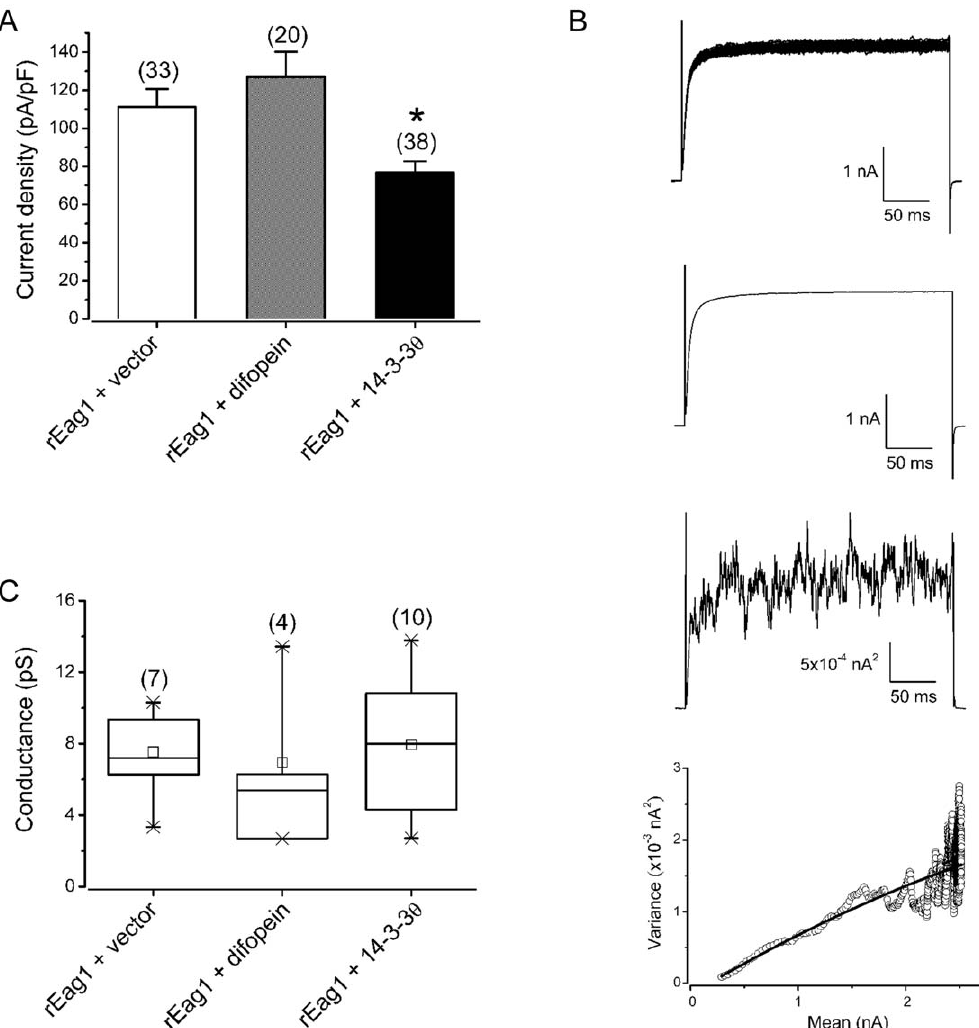
Figure 10. Estimation of the single channel conductance of rEag1 channel under different co-expression paradigms. rEag1 K + channels were co-expressed with either the control vector, difopein, or 14-3-3 h in HEK293 cells. ( A ) Comparison of the mean current density (pA/pF) at + 40 mV: rEag1 + vector, 111.2 6 9.5; rEag1 + difopein, 126.9 6 13.2; rEag1 + 14-3-3 h , 76.8 6 5.8. The numbers in the parentheses refer to the number of cells analyzed, and the asterisk denotes significant difference from the rEag1 + vector control (*, t -test: p , 0.05). ( B ) Representative non-stationary fluctuation analysis of rEag1 K + currents. ( Top row ) Whole cell current traces were evoked by 300-ms depolarizations from 2 90 mV to + 40 mV, which were used to generate the ensemble mean ( second row ) and variance ( third row ). ( Bottom row ) The mean-variance plot (during the 300-ms test pulse, with the linear capacitative component eliminated)( open circles ) was fit with a parabolic function ( solid curve ) to estimate the single channel current (0.9 pA). ( C ) Box plot presentation of the distribution of the estimated single channel conductance. Mean values (pS): rEag1 + vector, 7.5 6 0.9; rEag1 + difopein, 7.0 6 2.3; rEag1 + 14-3-3 h , 8.0 6 1.1. No significant difference was found among the three co-expression conditions (One-way ANOVA: p .